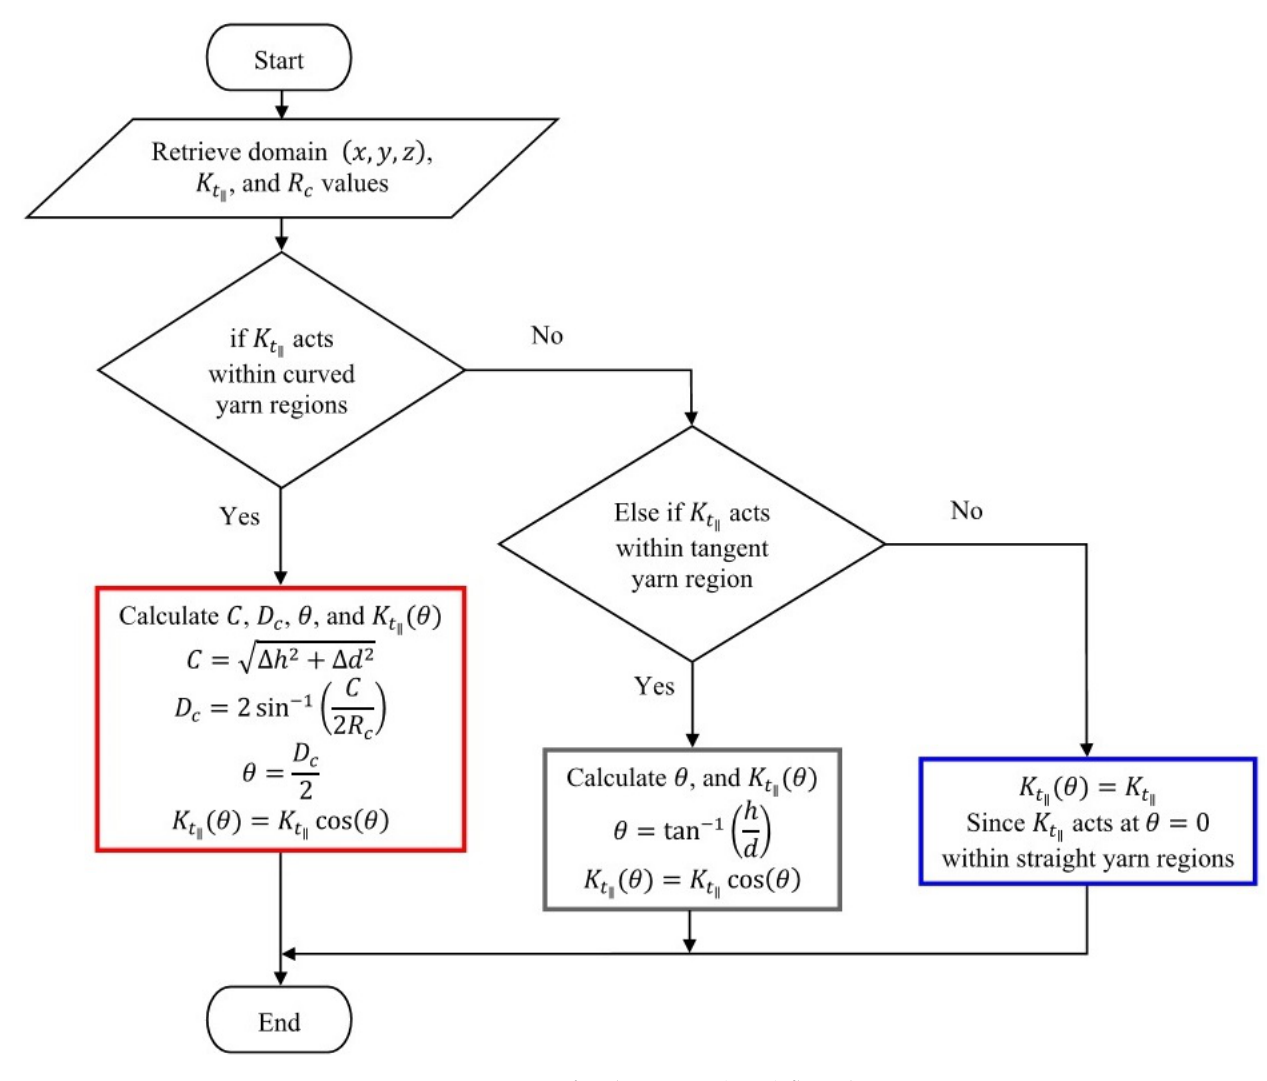
Figure 4. User-Defined Function (UDF) flow